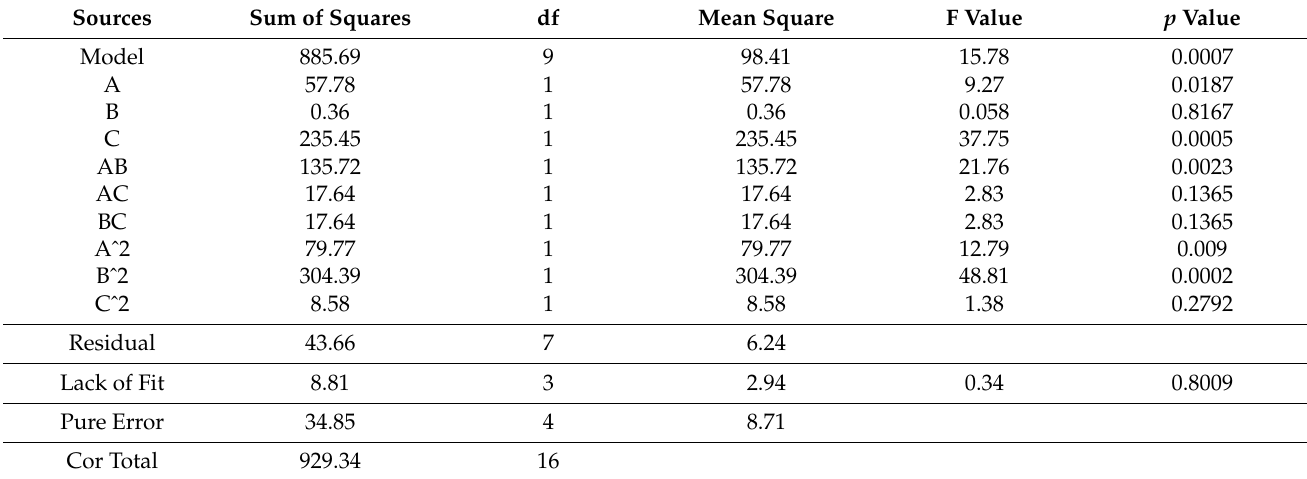
Table 4. Analysis of variance for the effects of corona electrode angle, corona electrode distance, and discharge power on the residual film separation